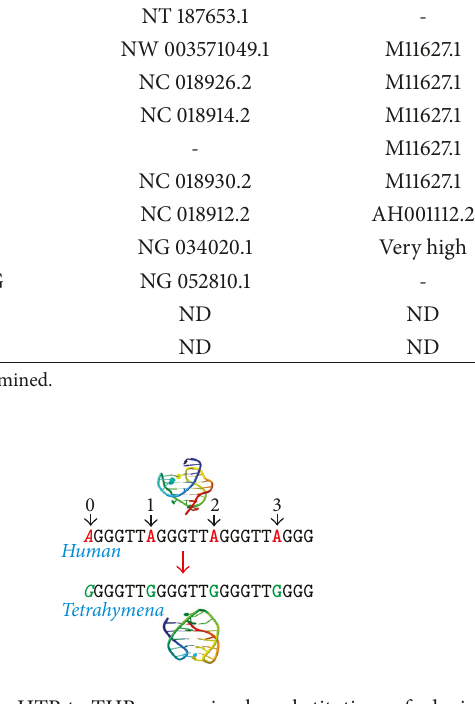
Figure 1: The HTR to THR conversion by substitutions of adenine for